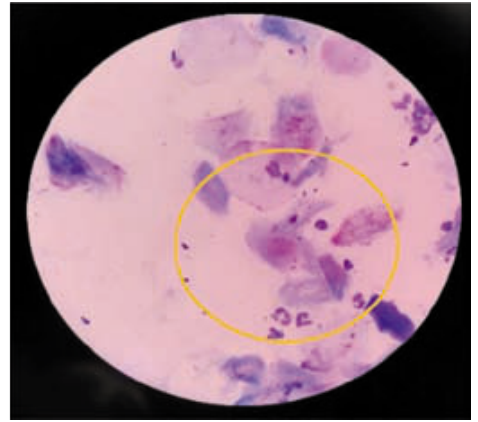
Fig. 3. Impression smear with yeast, corneocytes and